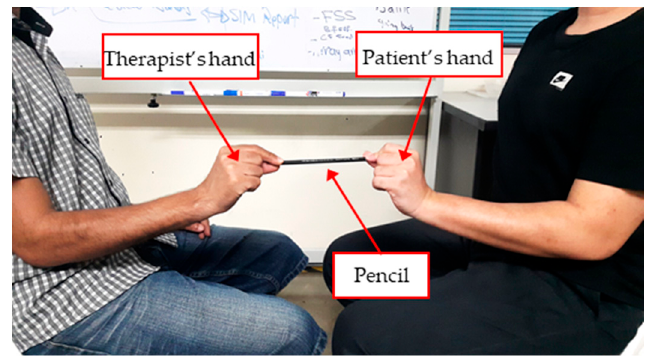
Figure 1. Pinch test as in the UE-FMA protocol.